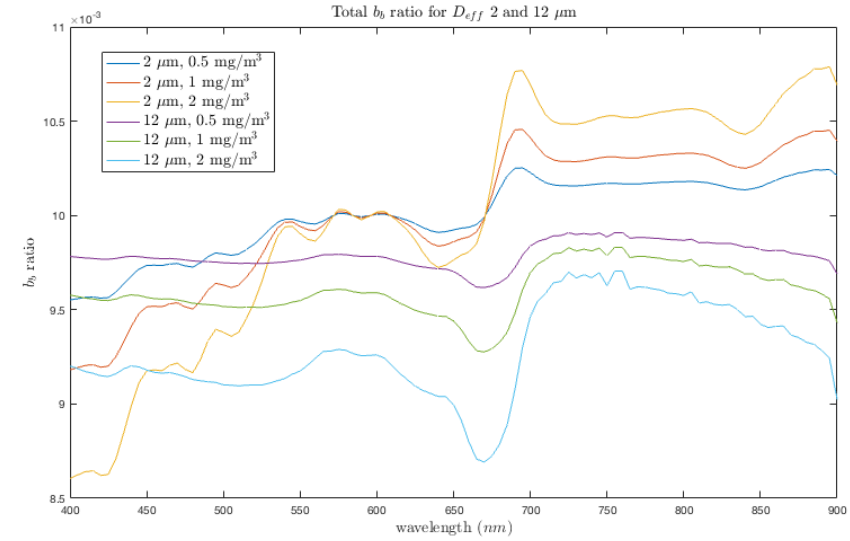
Figure A4. Bulk backscatter ratio shown for D ef f 2 and 12 µ m, with nominal b bnap (550) = 0.01 m − 1 and b nap as 50 times the b bnap , as for a coastal environment, shown for Chl a of 0.5, 1.0 and 2.0 mg/m 3 . The elevated backscatter ratio of coastal environments with respect to the Southern Ocean (where b nap is modelled as 100 times the b bnap ) is attributed to the contribution of terrestrial mineral particles with a high refractive index